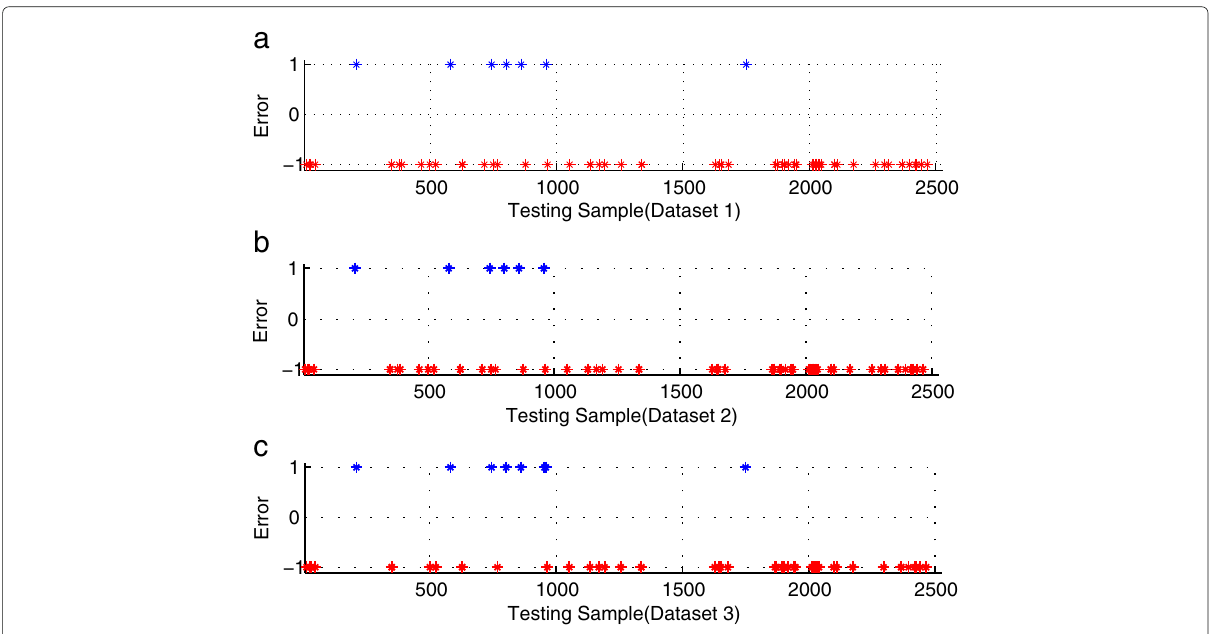
Fig. 6 Residual error plot. a Dataset 1. b Dataset 2. c Dataset